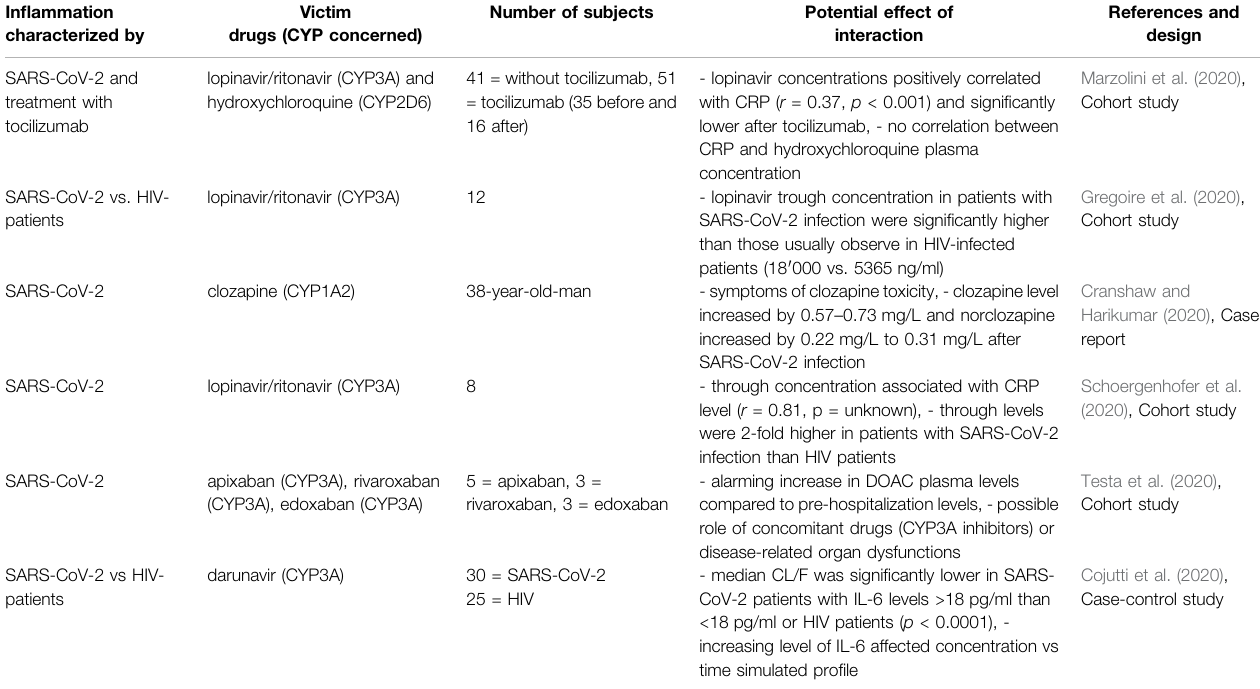
TABLE 2D | Impact of SARS-CoV-2 on CYP substrates, explained totally or partially by modulation of CYP activity. In fl ammation characterized